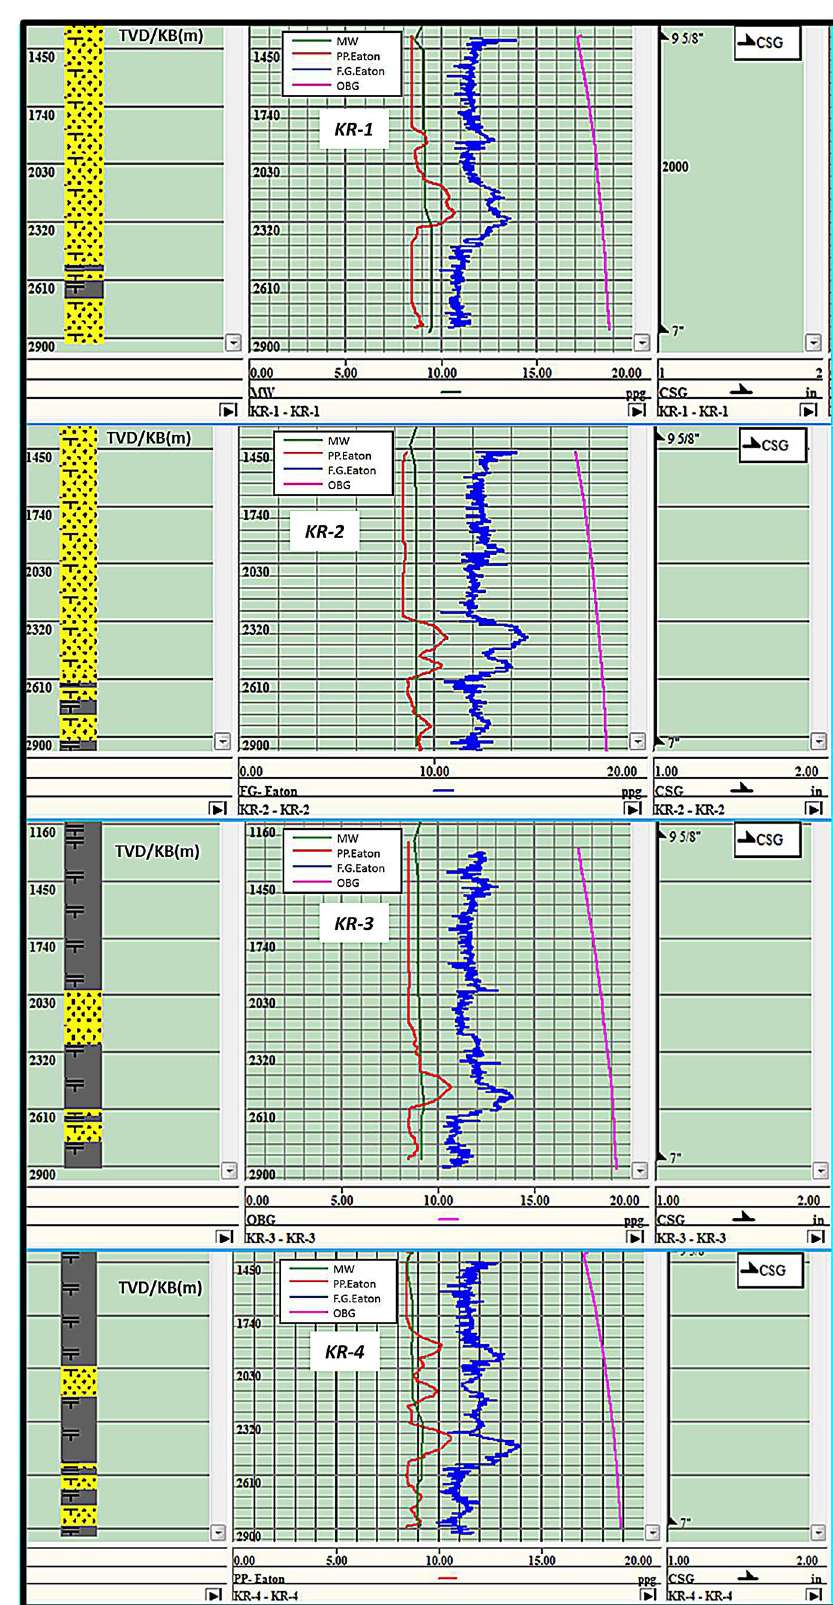
Fig. 6 Modelled geopressure gradients for well post-calibra-